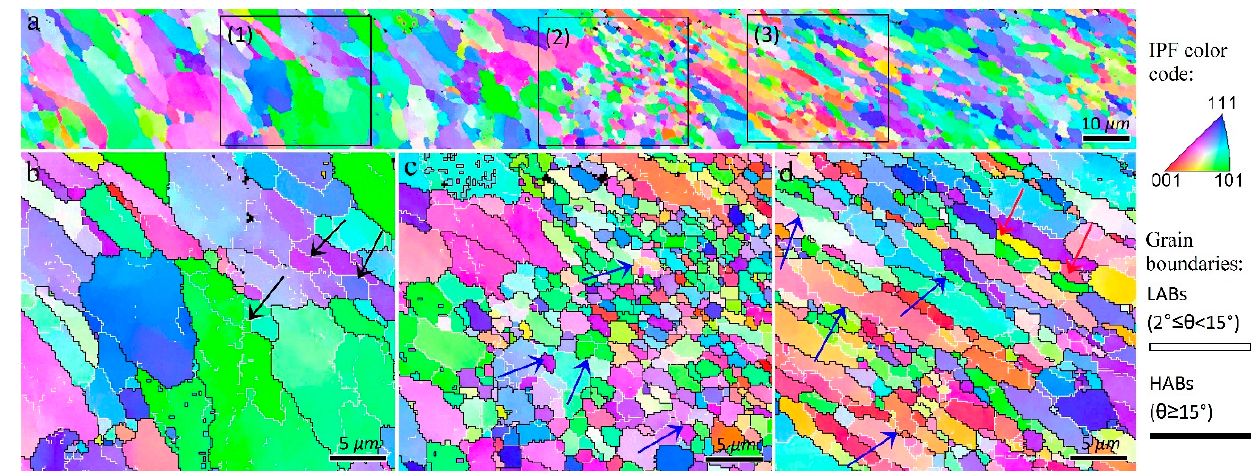
Figure 3. ( a ) Inverse pole figure maps of the rectangle 1 in Figure 2b. ( b – d ) Higher magnified views of the zones 1–3 indicated in ( a ). Black arrows in ( b ) refer to the LABs. Blue arrows in ( c , d ) show the continuous dynamic recrystallization mechanism occurring by transformation of LABs to HABs. The red arrows in ( d ) mention the fibrous grains in which the geometrically dynamic recrystallization (GDRX) arises.